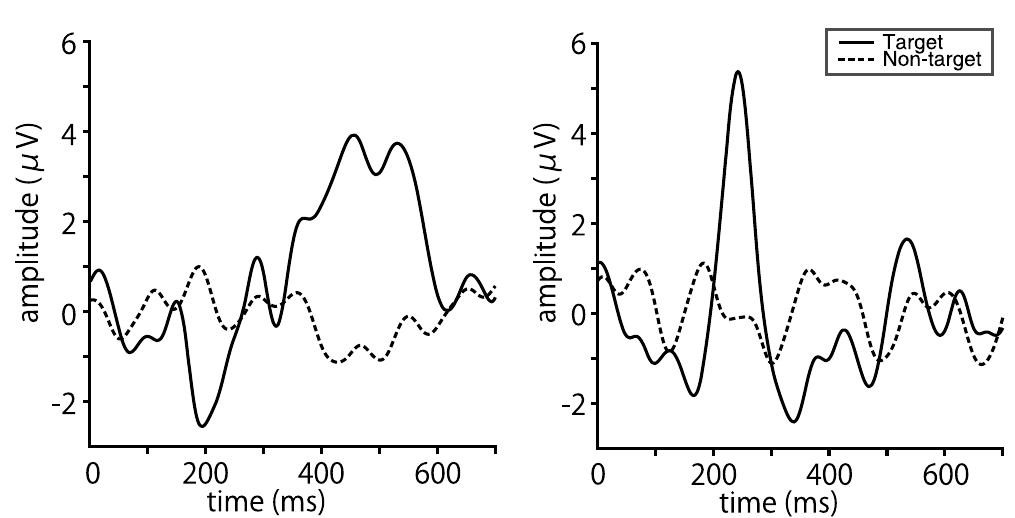
Figure 4. EEG waveforms in DMD and controls. EEG waveforms obtained from P4 electrodes, averaged for patients with DMD and controls, are shown. The 700 ms waveforms extracted from the onset of intensification were averaged. Solid lines indicate the target ERPs and dashed lines indicate non-target ERPs. In the controls, two positive peaks are shown at approximately 243 and 535 ms after the onset of stimuli, whereas in the DMD group, no clear peak corresponding to the early component was evident, but a blurred peak was seen at approximately 450–550